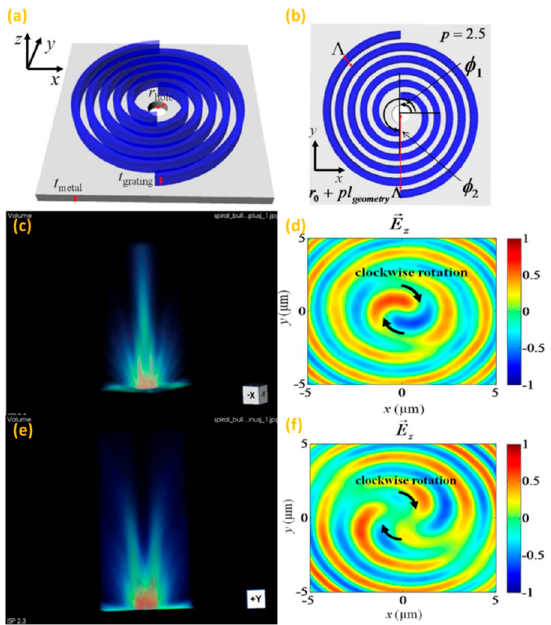
Figure 16. ( a , b ) Schematic diagram of the proposed double-spiral configuration with a central hole used for numerical calculation; 3-dimensional (3D) view of the electric field intensity distribution of such a structure with LCP light incidence ( c ) and RCP light incidence ( e ) ranging from 0 to 20 µ m above the dielectric grating layer and ( d , f ) the vertical electric field ( E z ) distribution on the corresponding z = 10- µ m plane ( c , e ) respectively. Reproduced with permission from [58]. Copyright Optical Society of America,